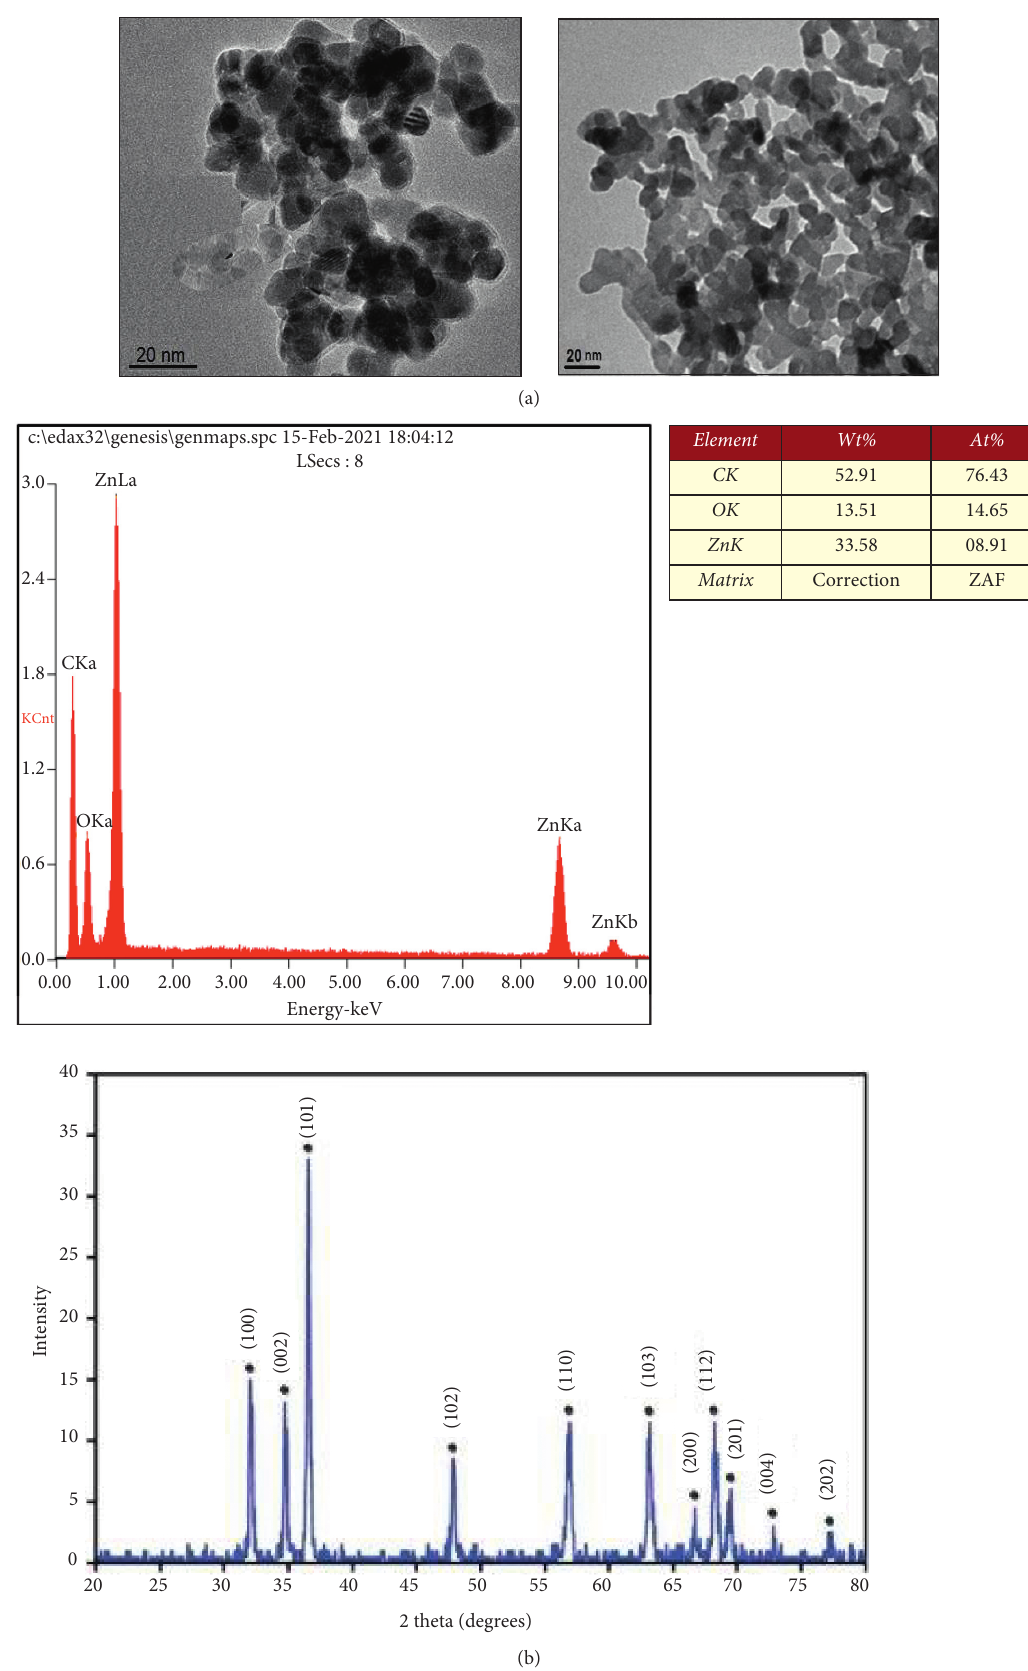
Figure 1: (a) TEM images of nanoparticles: (i) unmilled and (ii) ball milled. (b) EDX test result and XRD